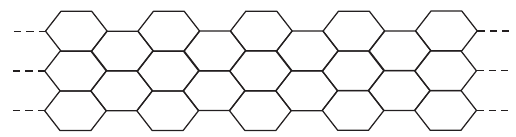
Figure 3: The 3D lattice of the zigzag TUZC 6 [10, 7]